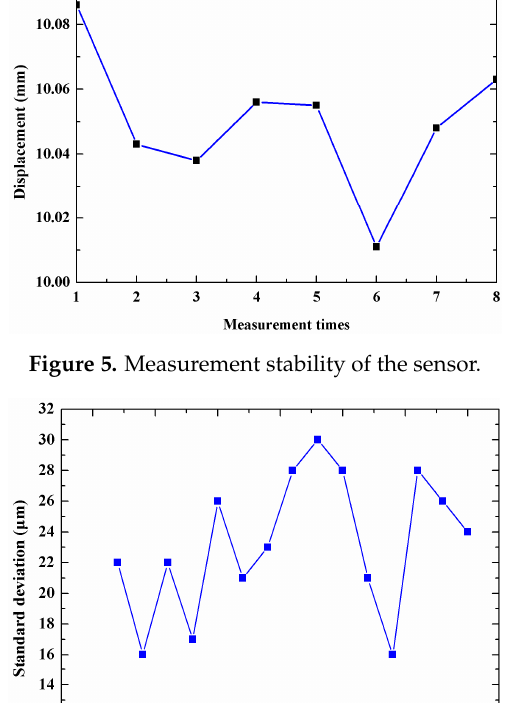
Figure 5. Measurement stability of the sensor.